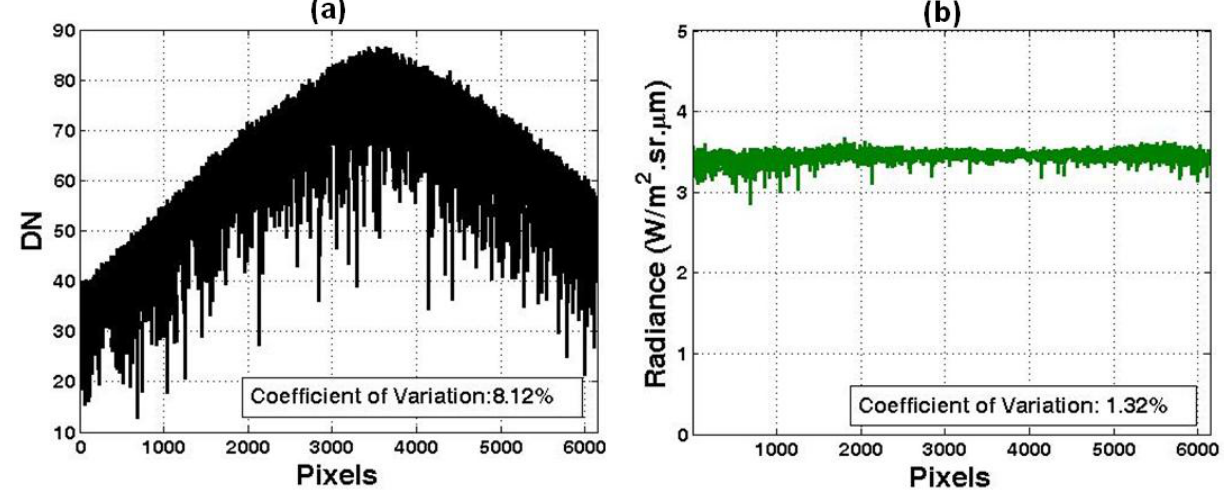
Figure 7. Same as Figure 6 but for the Red band with an integration time of 300 